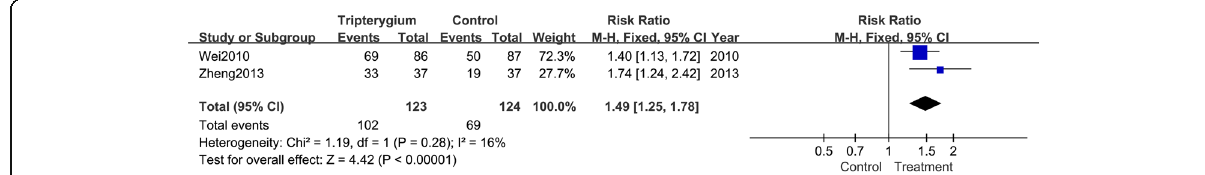
Fig. 9 Meta-analysis of Quality of daily activity. CI indicates confidence interval